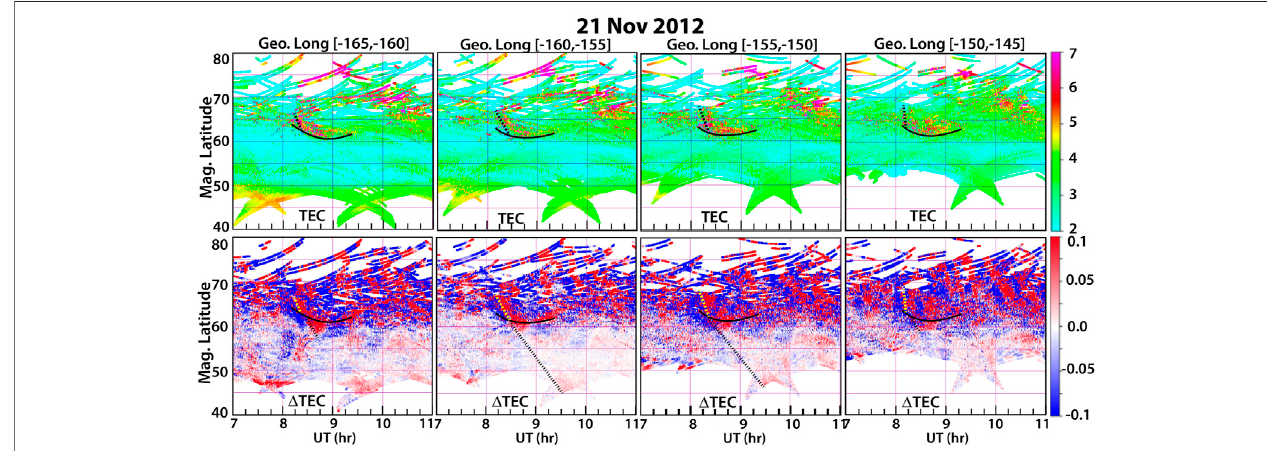
FIGURE 8 | Average TEC and Δ TEC over 5 ° geographic longitude increments from west of, to near, Poker Flat on November 21, 2012 in the same format as Figure 4 .